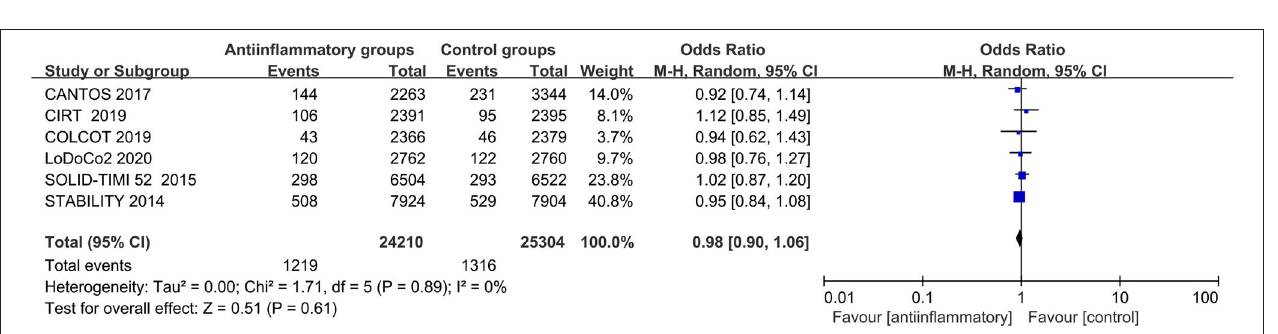
FIGURE 8 | Forest plots of studies evaluating cancers in patients receiving anti-inflammatory agents vs.